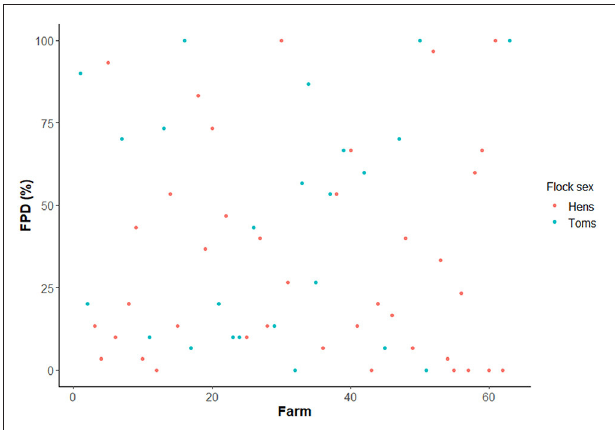
FIGURE 2 | Percentage of birds affected with FPD (score > 0) in the scored subsets of the surveyed flocks (N Flocks =